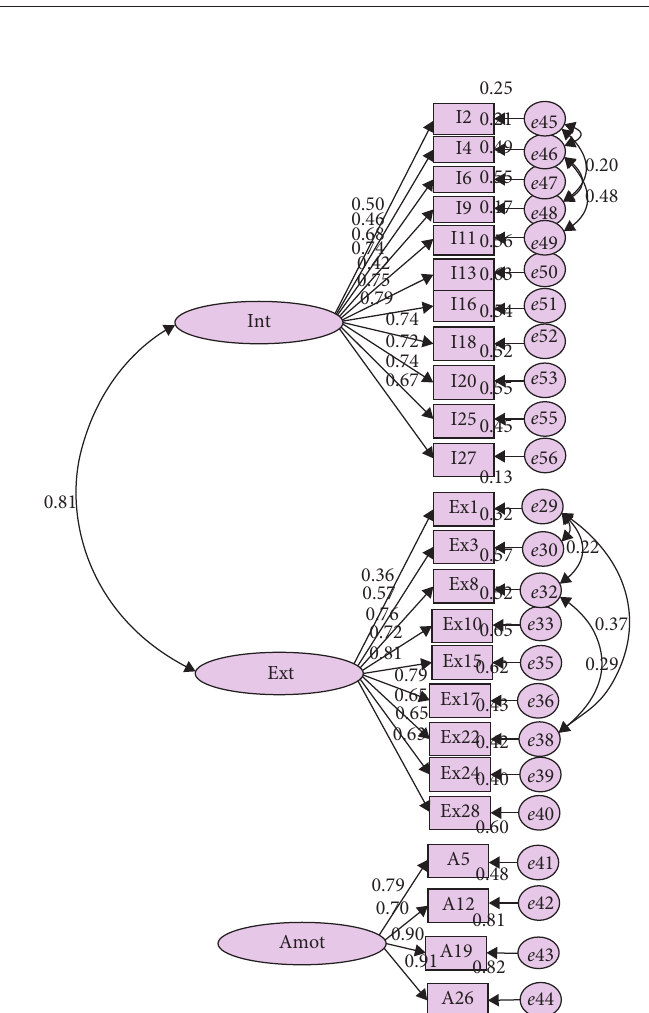
Figure 1: Modifications made in light of the logical and theoretical justifications.